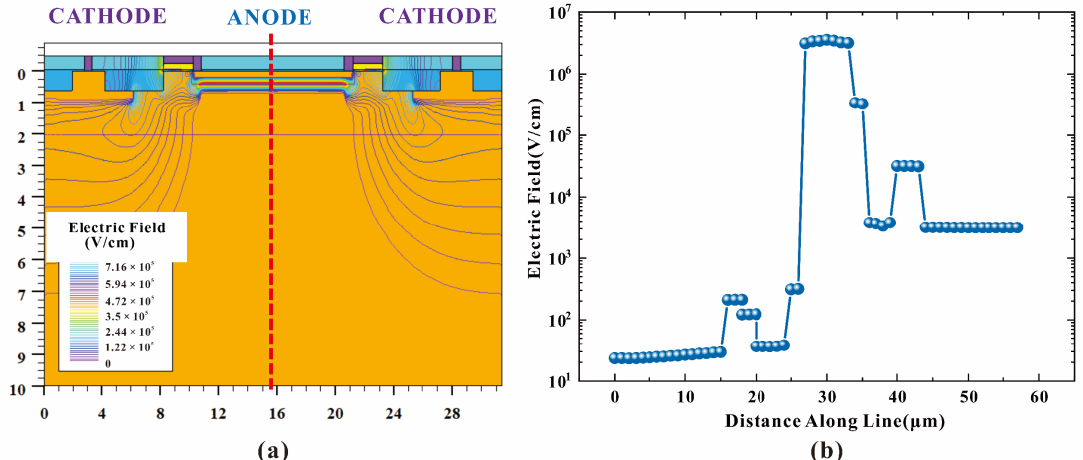
Figure 3. Two-dimensional electric field distribution of HDEPD device ( a ) and one-dimensional tangent distribution of electric field in HDEPD device ( b ).